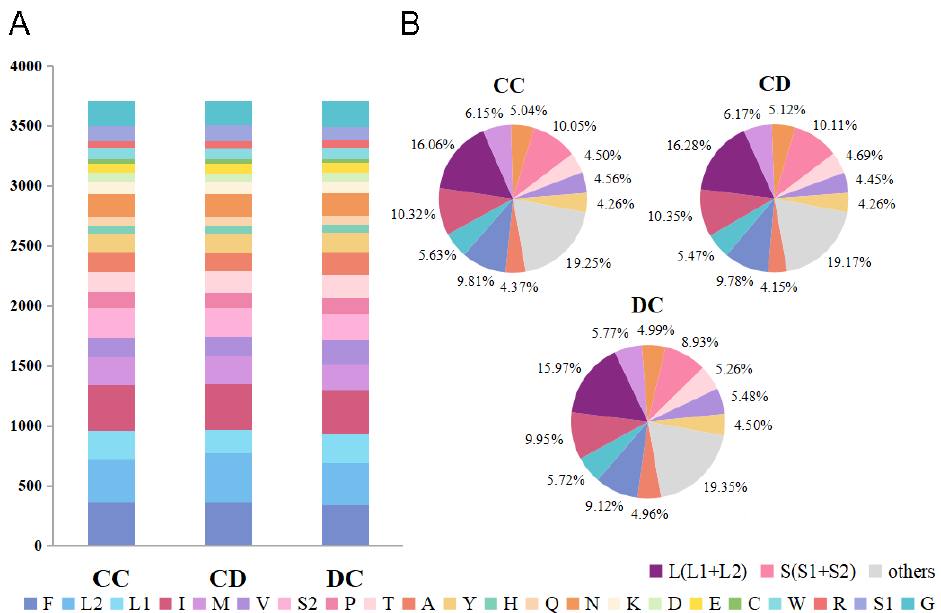
Figure 2. Numbers of different amino acids in the mitogenomes of the three Buprestidae species ( A ) and the percentage of top 11 amino acids with higher number ( B ); the stop codon is not included. CC: Coomaniella copipes , CD: Coomaniella dentata , DC: Dicerca corrugata .